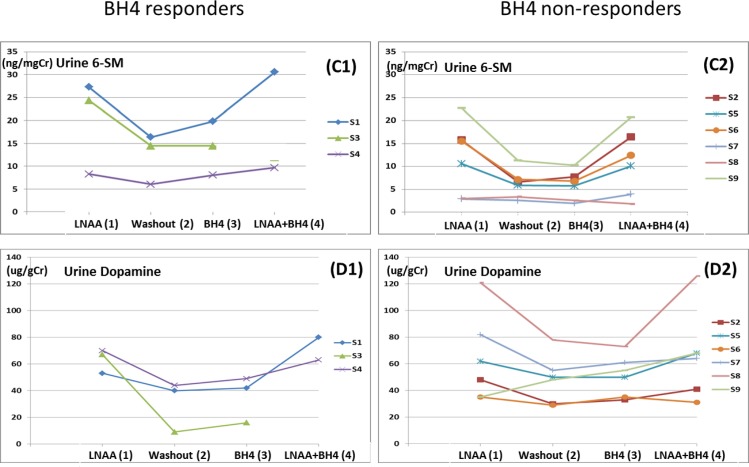
Urine 6-sulfatoxymelatonin (C) and Urine dopamine concentrations (D) over the 4 phases.Phase 1 (LNAA), Phase 2 (Washout), Phase 3 (BH4) and Phase 4 (BH4+LNAA). C1 and D1: BH4 responders. C2 and D2: BH4 non-responders. The data point at Phase 4 in S3 is missing due to sample collection failure.